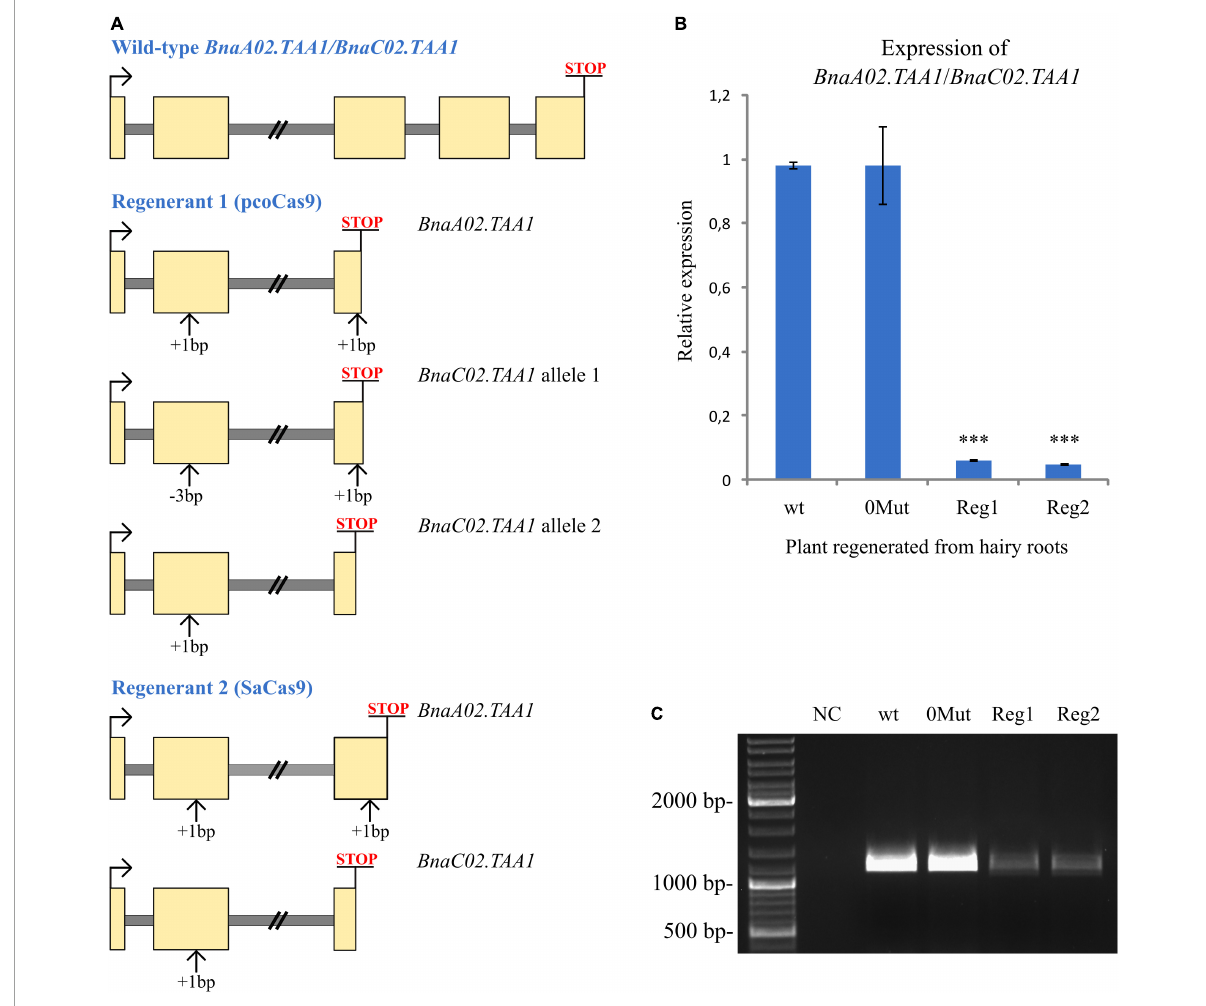
FIGURE4 Expression analysis of BnaTAA1 genes. (A) Schematic representation of the indel influence on the coding regions in selected mutant lines. Exons are in yellow and introns in gray. The premature stop codon is highlighted. (B) RT-qPCR analysis of BnaTAA1 genes in selected T0 regenerated plants. wt, regenerant derived from wild-type hairy roots considered as a control. 0MUT, regenerant with no mutation in BnaTAA1 genes. Reg1 and Reg2, T0 BnaTAA1 mutant plants. The data represent mean ± SD ( n = 3) of normalized and rescaled expression levels. Significantly different expression levels are indicated by asterisks (one-way ANOVA; Dunnett’s test; p < 0.0001). (C) Amplification of the coding regions of BnaA02.TAA1 and BnaC02.TAA1 and partial 5 (cid:48) and 3 (cid:48) UTRs by RT-PCR in pistils of T0 regenerants. No alternative splicing of CRISPR/Cas9-targeted exons was detected in non-mutated regenerant (0MUT) or mutant plants (Reg1 and Reg2). NC, negative control of